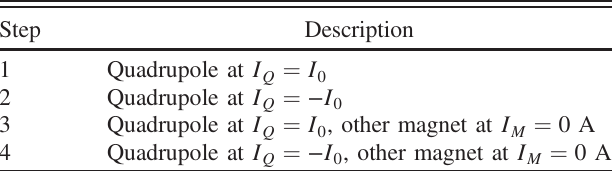
TABLE IV. Magnet settings for quadrupole to other magnet cross talk measurements. The cycling current was 110 A and the cross talk was measured at I 0 ¼ 85 A (see Fig. 3). All the field integral scans were performed by moving the two extremities of the wire on a synchronized circular trajectory, and measuring the voltage on the fly. The parameters of the measurement sequence are given in Table V.